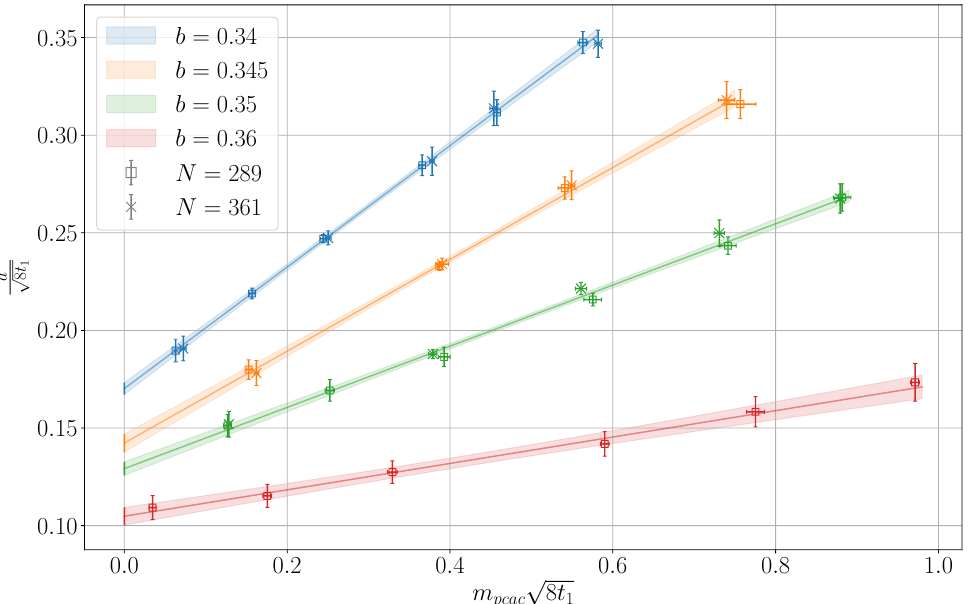
Figure 13. The lattice spacing expressed in units of the gradient flow scale √ 8 t of the adjoint PCAC mass in physical units. Different markers represent a different number of colours N (volume). The straight lines represent the extrapolation of the lattice spacing to the massless-gluino limit, obtained through a joint fit to all the points for each b . The error bars on the y -coordinate are dominated by systematics — see table 5 — while those on the horizontal axis take only into account the errors on the bare PCAC